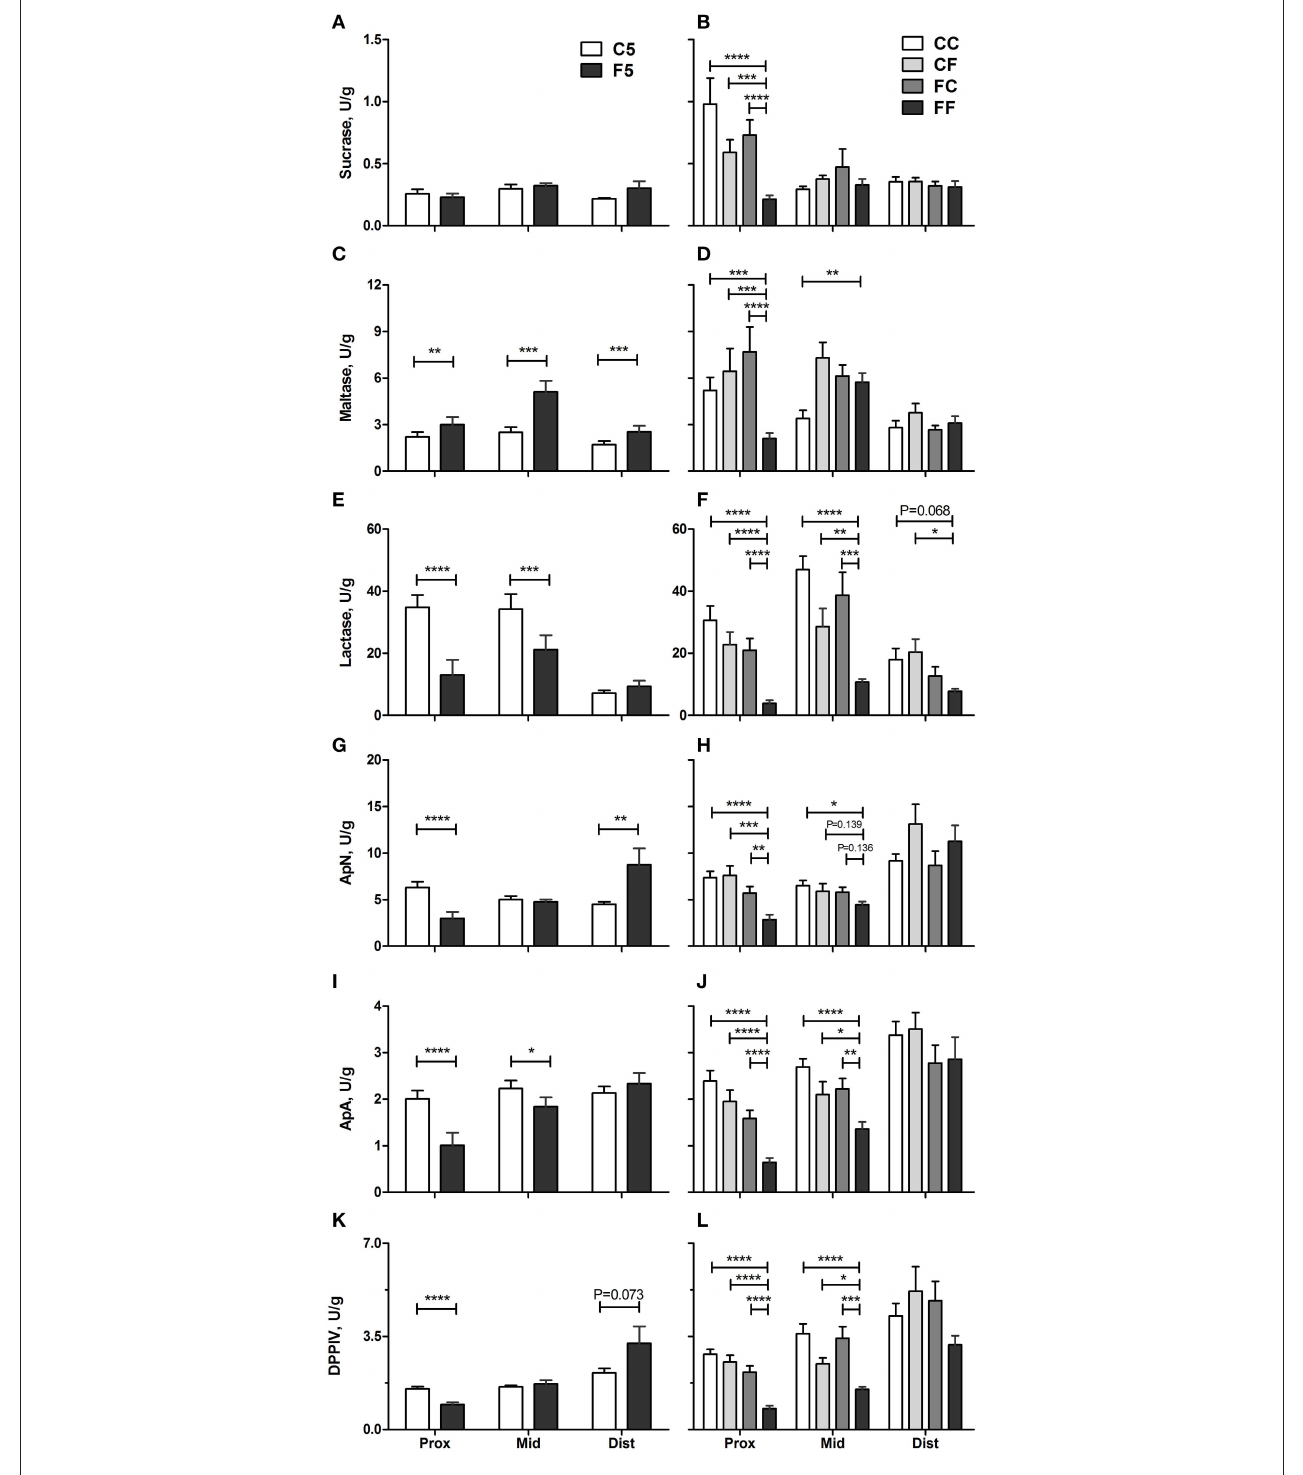
FIGURE 6 | Brush border enzyme activities. Sucrase (A,B) , maltase (C,D) , lactase (E,F) , ApN (G,H) , ApA (I,J) , and DPPIV (K,L) in the proximal, middle, and distal small intestine. Values (means ± SEM) designated with asterisks are significantly different, * P < 0.05, ** P < 0.01, *** P < 0.001, **** P < 0.0001. n = 11 each for C5 and F5 groups, and n = 12–14 for CC, CF, FC, and FF groups. ApA, aminopeptidase A; ApN, aminopeptidase N; C5, colostrum feeding until day 5; CC, colostrum feeding until day 9; CF, 4 days colostrum feeding followed by formula feeding until day 9; DPPIV, dipeptidylpeptidase IV; F5, formula feeding until day 5; FC, 4 days formula feeding followed by colostrum feeding until day 9; FF, formula feeding until day